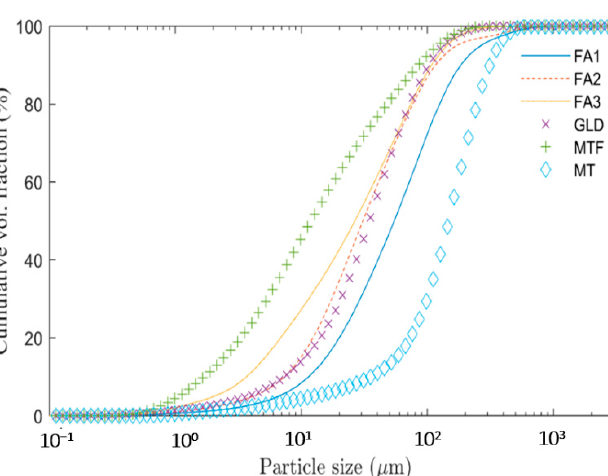
Table 4. Circularity, convexity and aspect ratio of each sample.